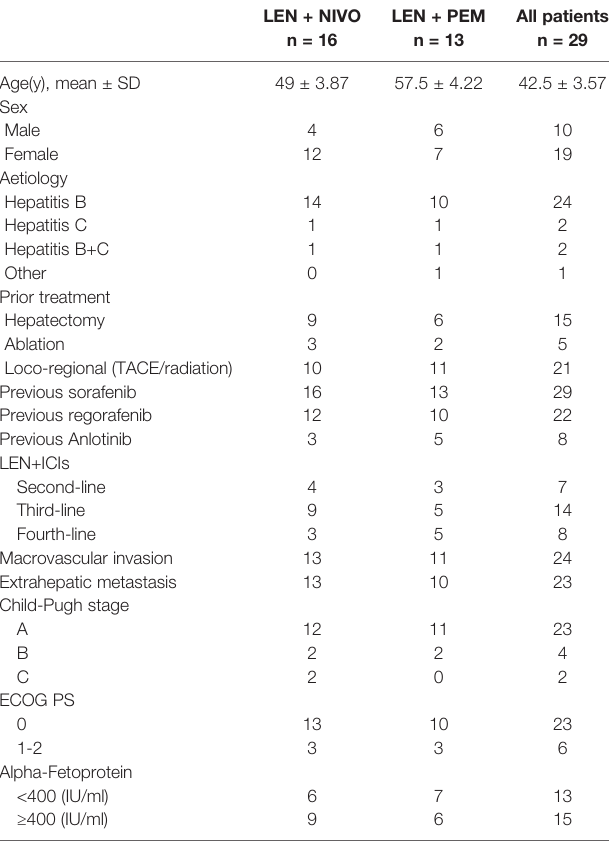
TABLE 1 | Baseline